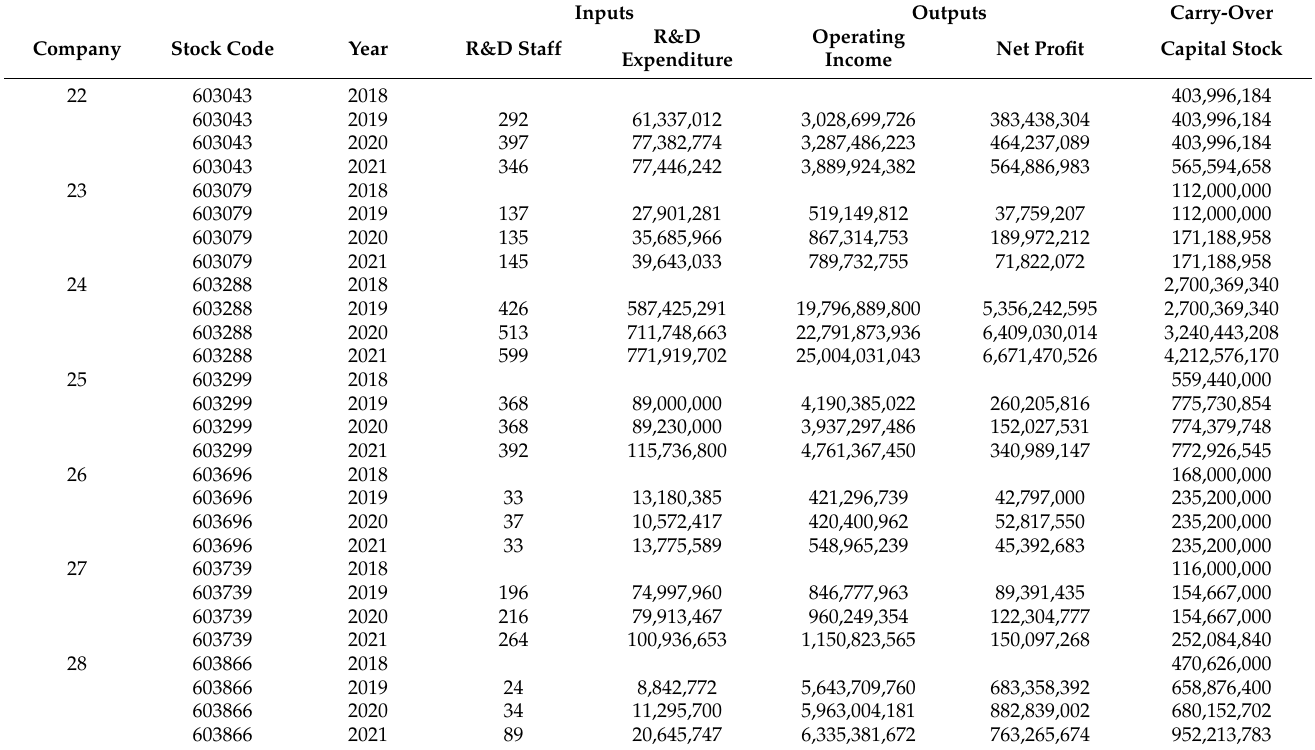
Table A1. Cont. Inputs Outputs Carry-Over